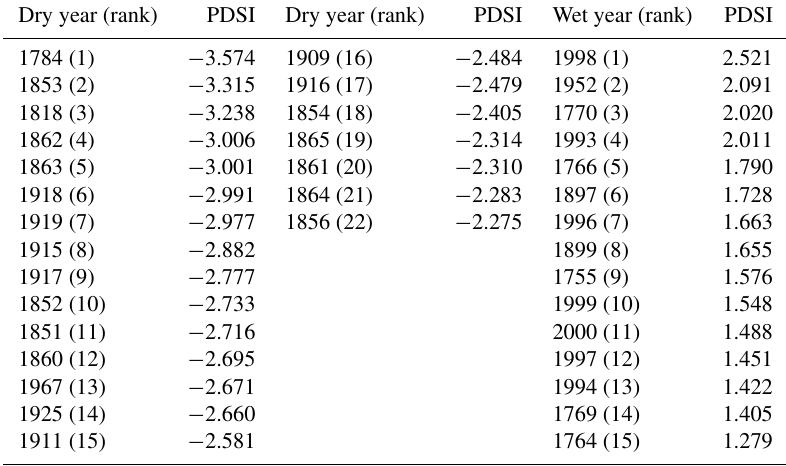
Table 4. Reconstructed extreme dry–wet years and annual PDSI of the Daxing’an Mountains.